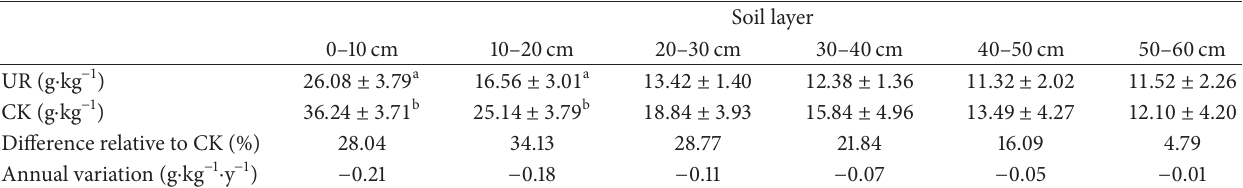
Table 3: Comparison of SOC content in different stands (mean ± SD, 𝑛 = 30).